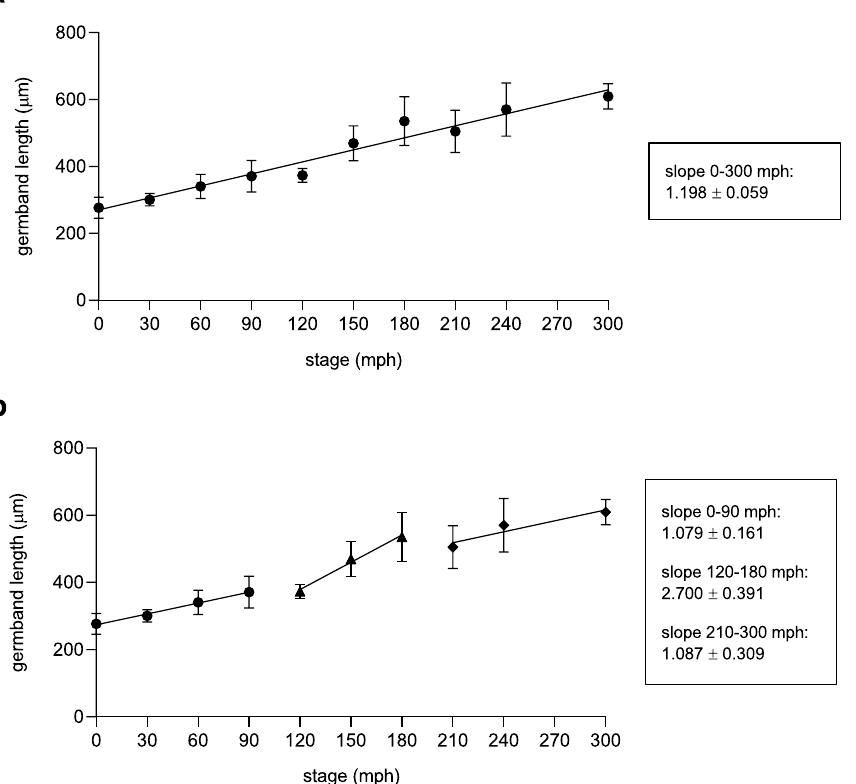
Figure 3. Cell proliferation peak correlates with an increasing in the elongation rate. ( a ) Germband’s length throughout elongation measured every 30 min from 0 to 300 mph (n = 10 at each stage; 270 mph was not counted) after linear regression showed an average rate of elongation of 1.198 ± 0.059 µm/min. The slope represents the rate of elongation at each period. ( b ) Linear regression applied to separated periods of elongation showed 2 different slopes. The period between 120–180 mph showed to be statistically different to 0–90 mph ( p = 0.0001) and 210–300 mph ( p = 0.0029). All data were fitted with a linear regression. Error bars indicate SEM (n =